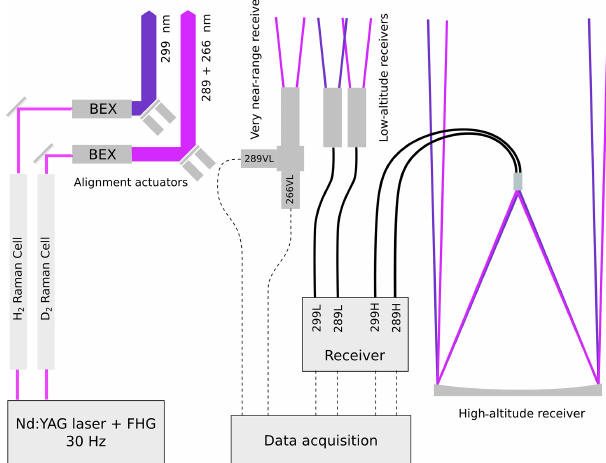
Figure 1. Current transmitter and receiver layout of TMTOL. BEX stands for beam expander. The new very near-range receiver is also